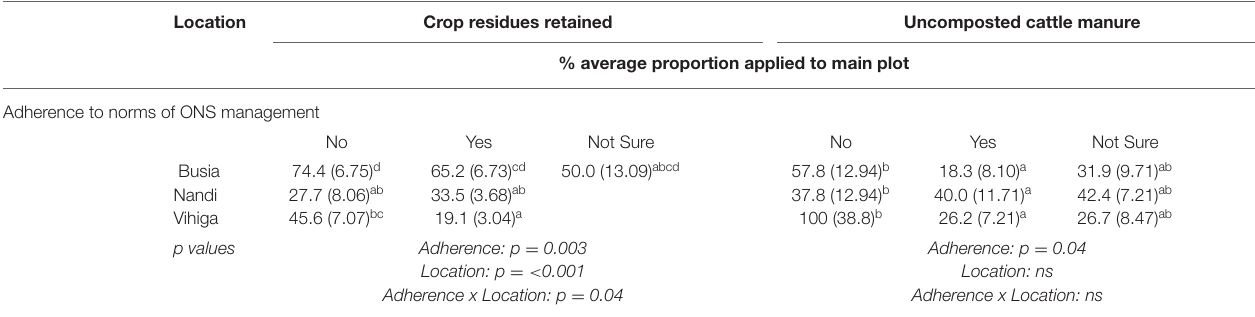
TABLE 8 | Percentage of total crop residues retained, and total uncomposted cattle manure applied to the main plot as influenced by adherence to social norms in three counties of western Kenya (Nandi n = 62 and Vihiga n = 62; Busia n = 60). Location Crop residues retained % average proportion applied to main